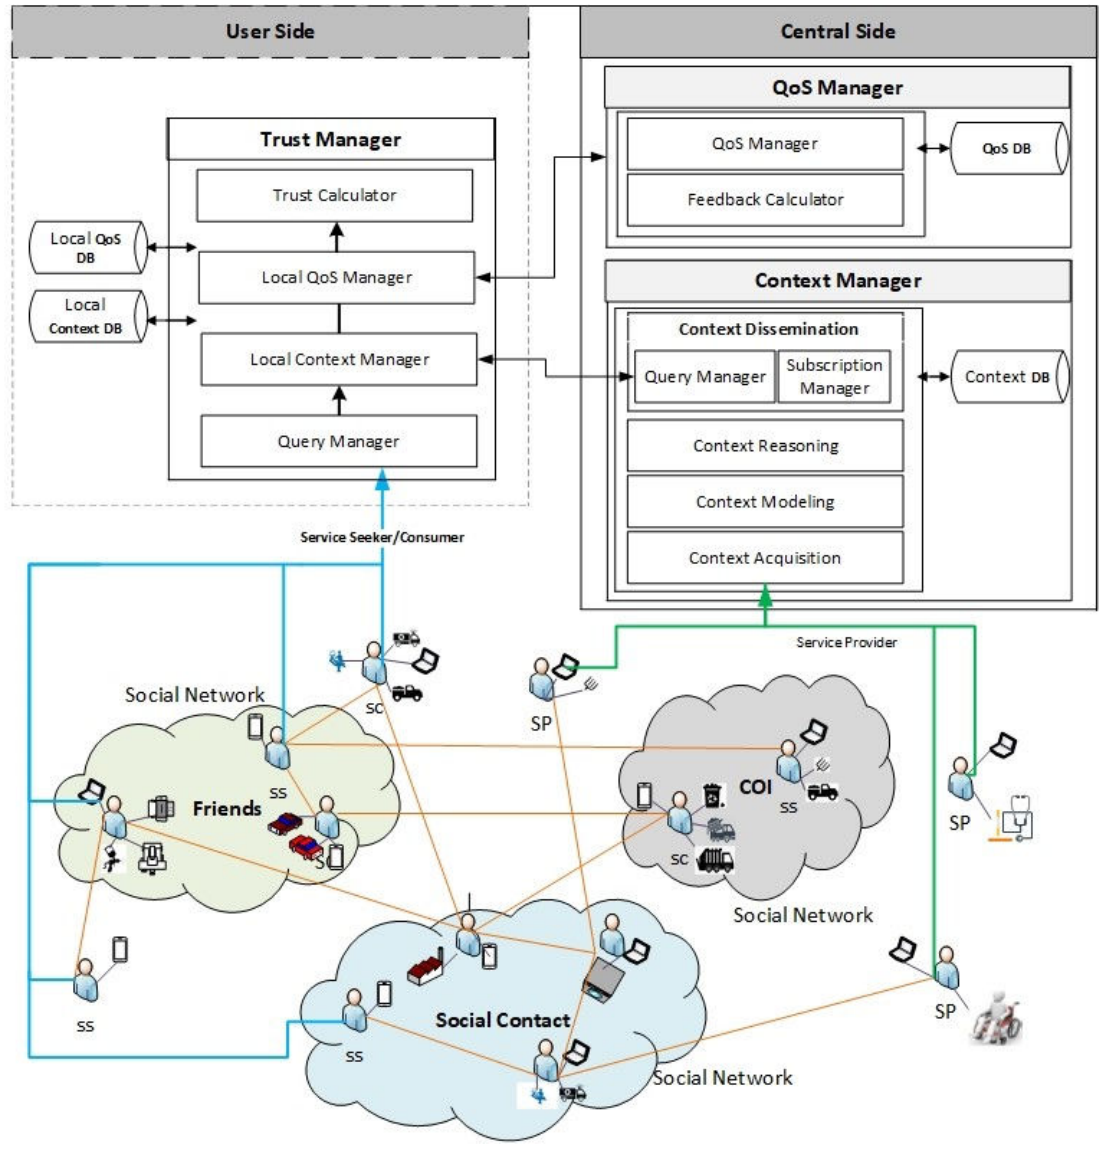
Figure 1. The Context Aware Trustworthy Social Web of